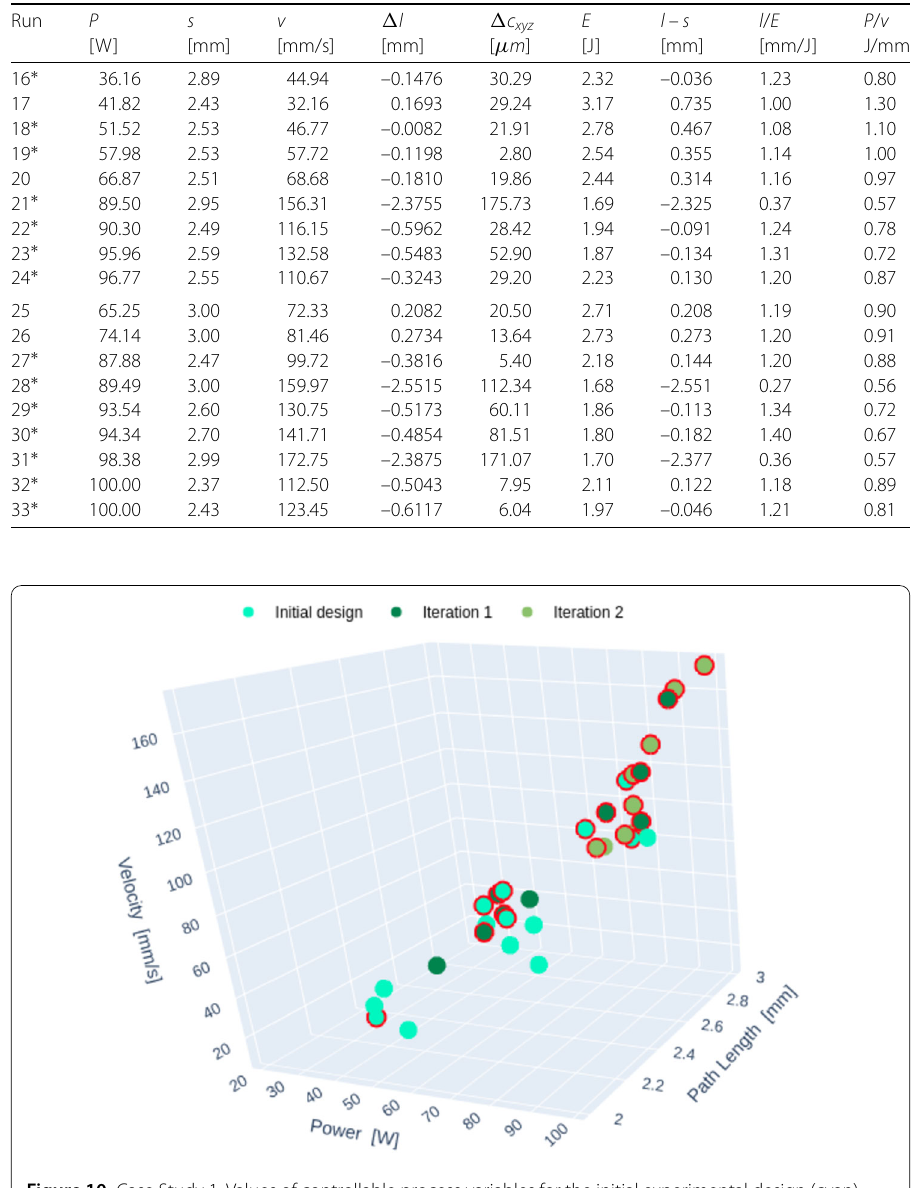
were evaluated and since the R 2 of both models are larger than 0.98 the method stopped and the final Pareto solutions are